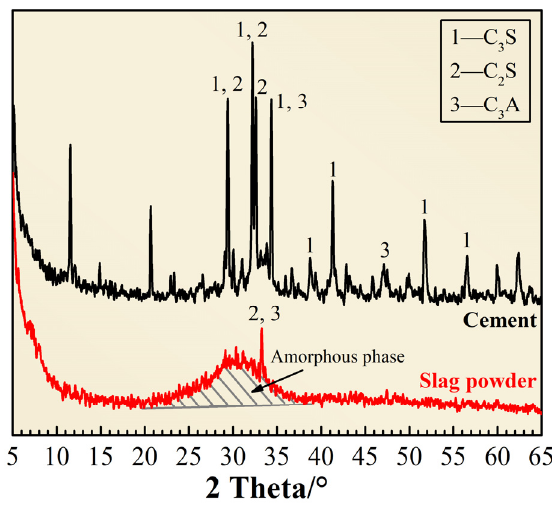
Figure 1. The mineral phase composition of cement and slag powder. Table 2. The mix ratio of CBRM-Paste.